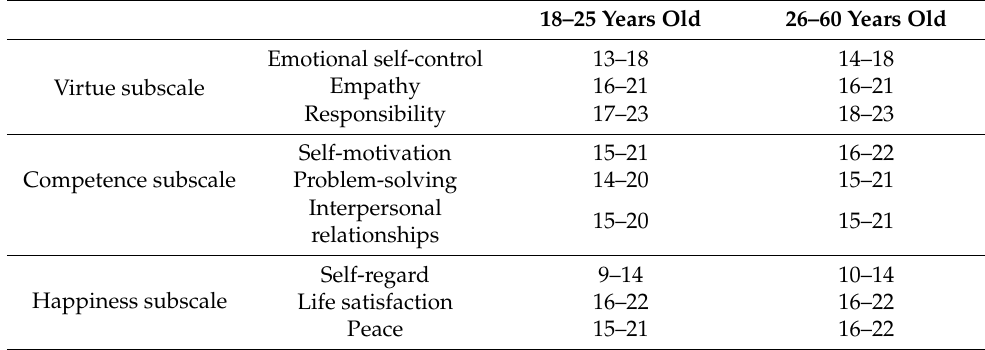
Table A1. The normal range of EI score in each subscale regarding